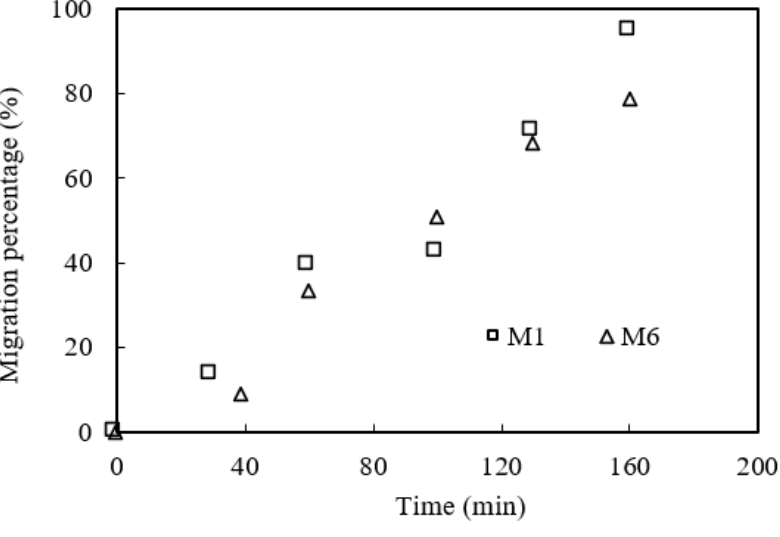
Figure 18. Effect of microtubule porosity.